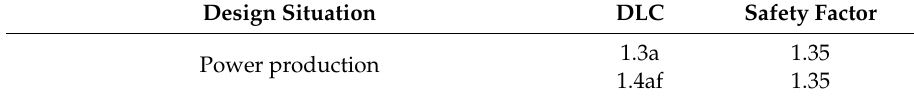
Table 4. Design load cases.